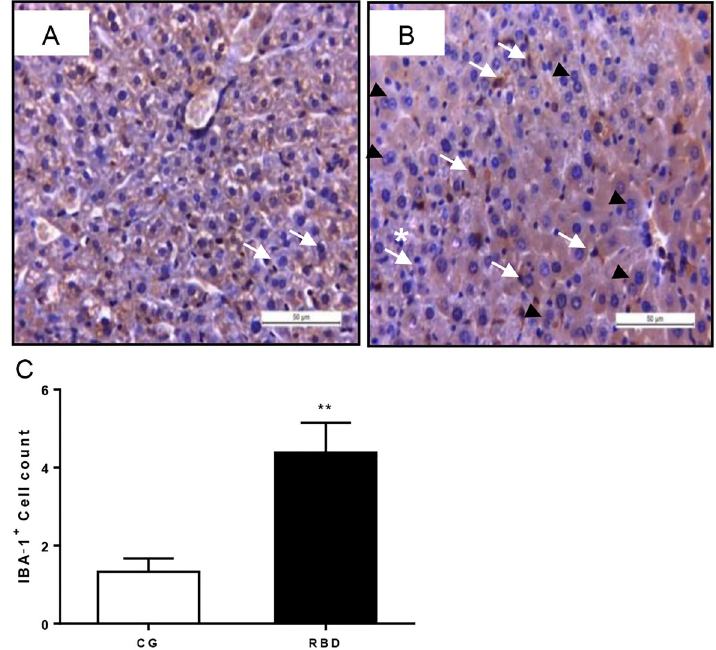
Figure 3. Representative liver ionized calcium-binding adapter protein-1 (IBA-1) immunostaining of the experimental groups, following 40 days of dietary intervention. A , Control nourished and B , regional basic diet (RBD) groups in high magni fi cation ( (cid:1) 400, scale bar 50 m m). White arrows indicate binucleated hepatocytes. Black arrowheads indicate IBA-1-positive cells. The asterisk indicates parenchyma disruption. Note lack of glycogen stores (seen by poorly stained cytoplasm in the nourished hepatic cells) and hepatocyte hypertrophy in the RBD-challenged liver. C , IBA-1-positive cell count. Data are reported as mean ± SE for n=6 per group. **P o 0.01, unpaired Student ’ s t -test.